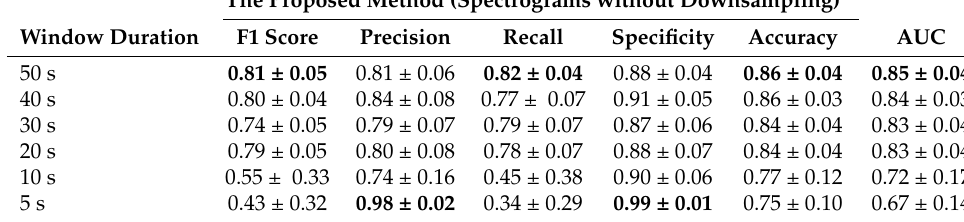
Table 3. Quantitative comparison on window length of log-spectrograms as the inputs of the proposed 2D-CNN + Channel-wise Attention method. The results are presented as mean ± standard deviation. The best performance is indicated in